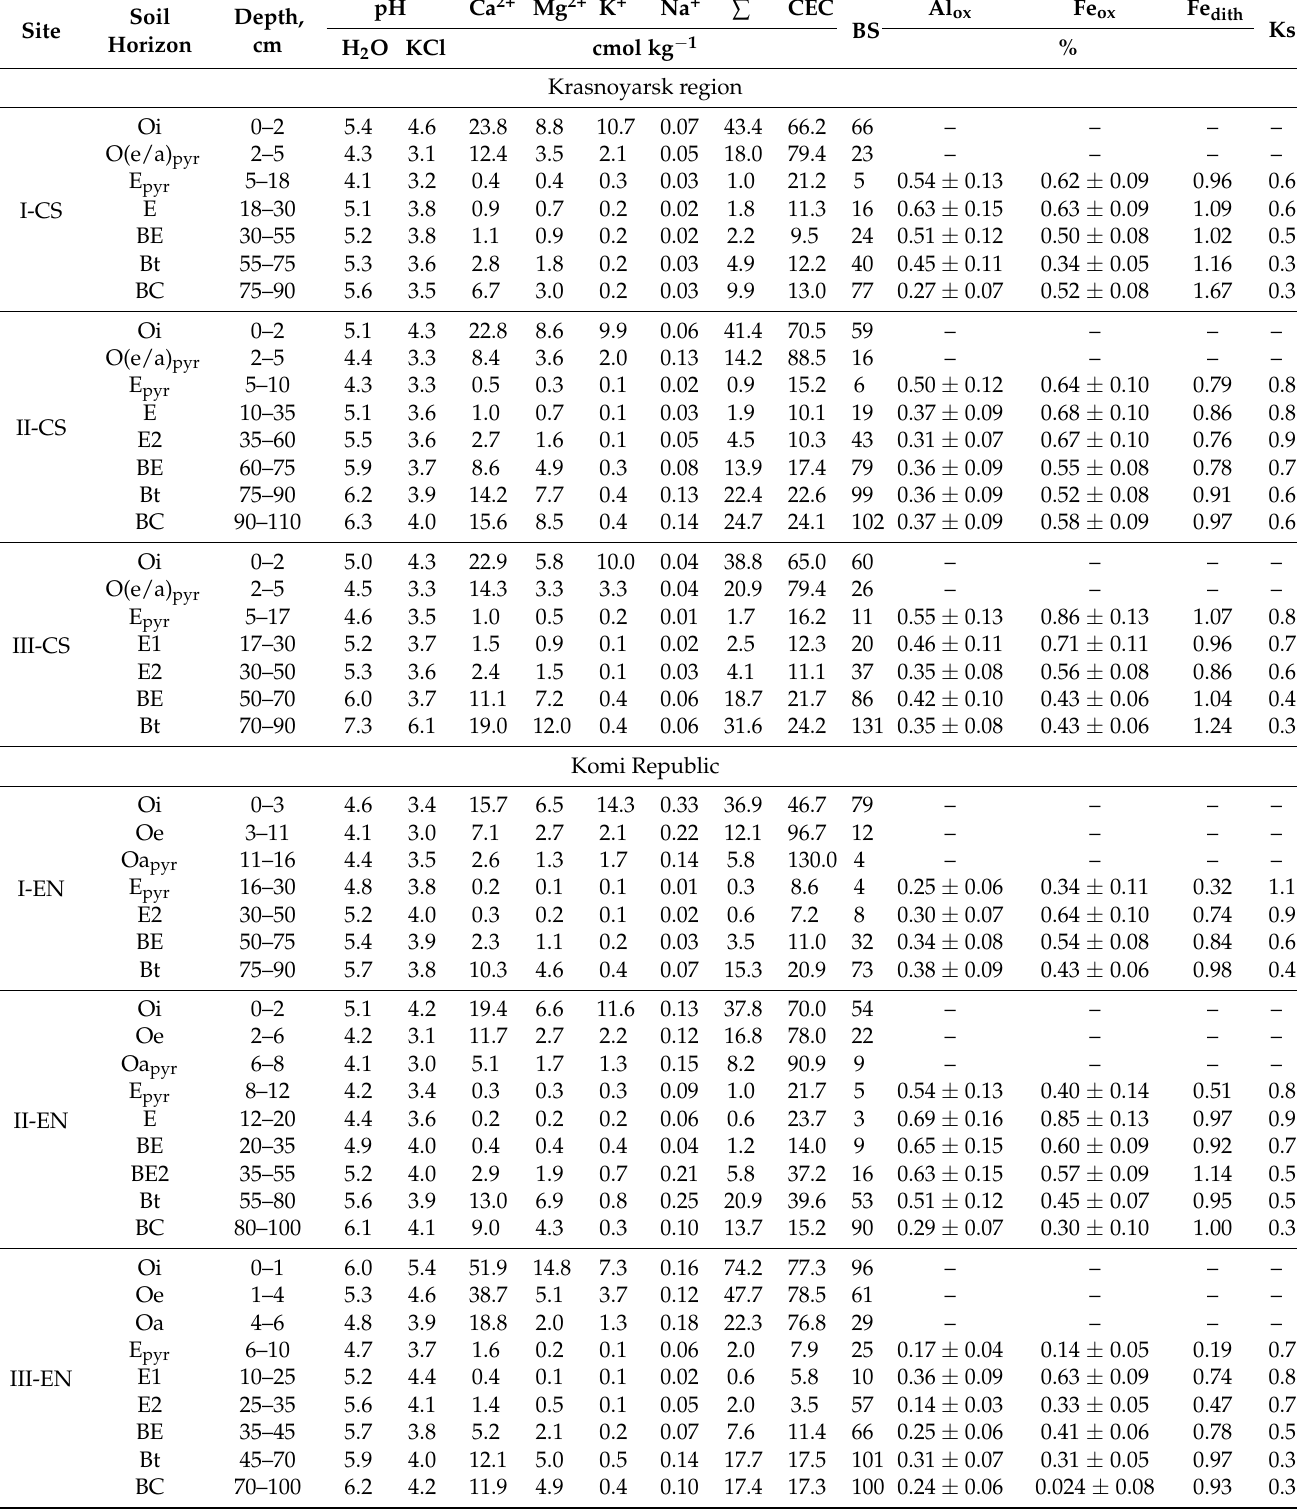
Table 2. Chemical properties of the studied